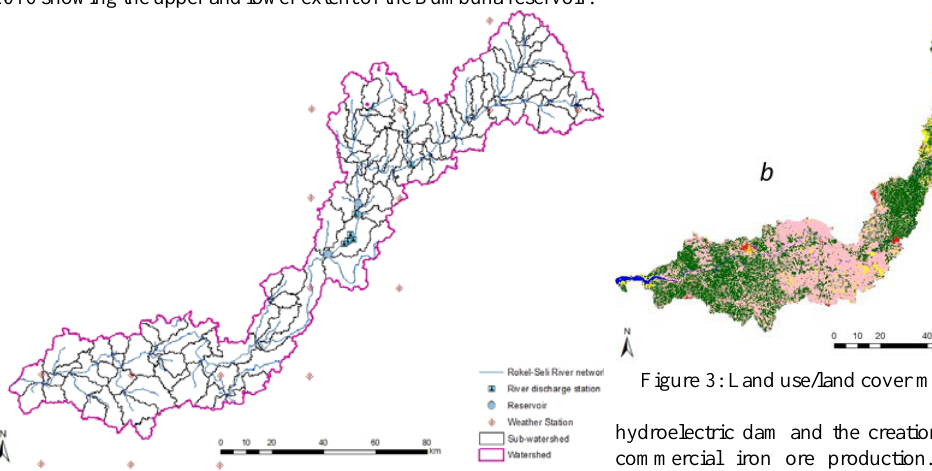
Figure 2: Simplified SWAT model for the Rokel-Seli River watershed